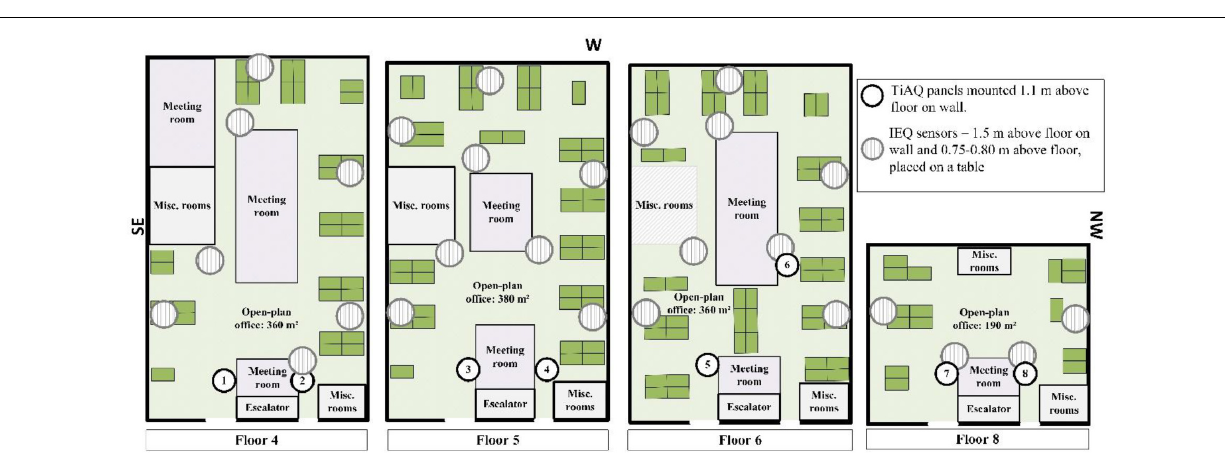
FIGURE 3 | Location of TiAQ, desks and deployed sensors in the four office spaces in the western part of building